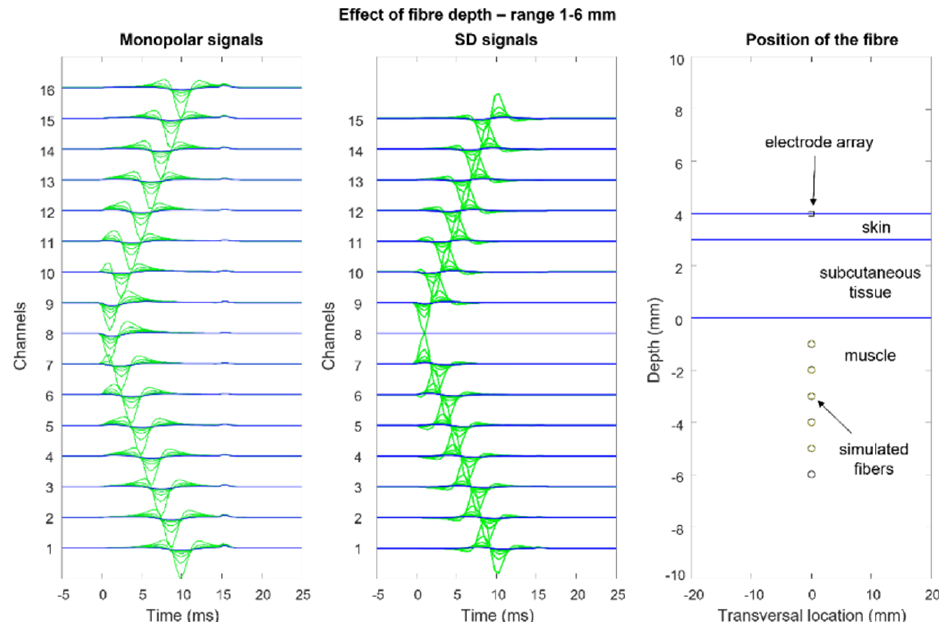
Figure 12. Effects of fiber depth within the muscle: skin thickness = 1 mm, subcutaneous (fat) tissue thickness = 3 mm, interelectrode distance = 5 mm. Observe how, in the monopolar recording, the end-of-fiber effect decreases slowly and becomes greater than the propagating component for depths near 8 mm within the muscle. This contributes to the crosstalk signal that is present on nearby muscles. (See animation in Supplementary Materials, Sup6). Reproduced from https://www.robertomerletti.